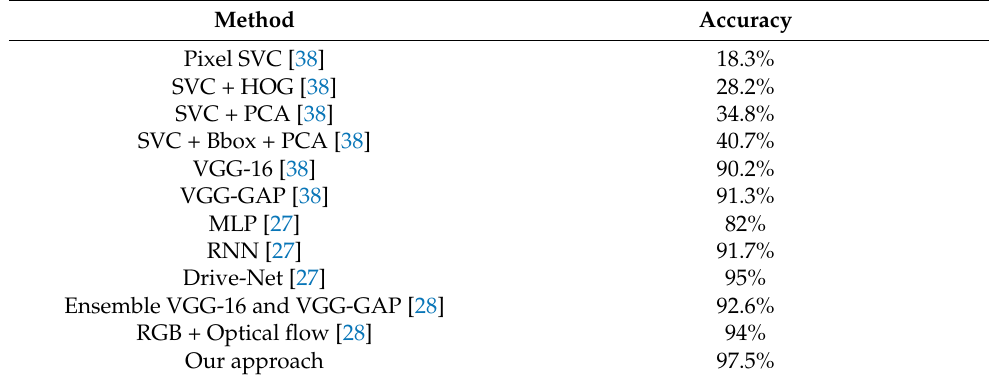
Table 6. Comparison of the proposed distracted driving detection with previous methods.